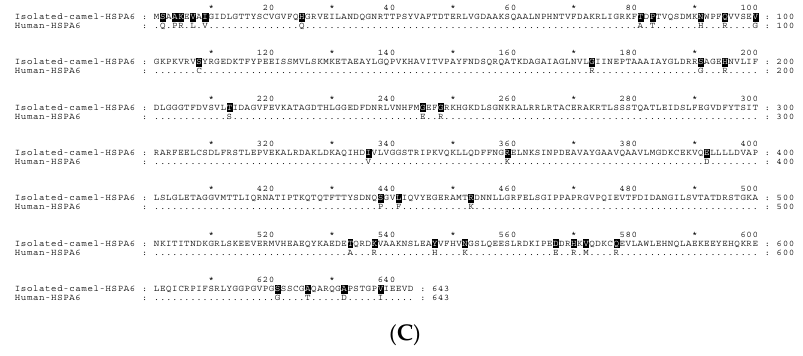
Figure 1. Homology analysis of the deduced amino acid sequences of cDNA clones of camel and human HSPs. Sequence alignment was produced by Clustal Omega and edited using GeneDoc version 2.7.000. ( A ) Amino acid alignment of camel and human CRYAB showing the four different amino acids shaded in black; ( B ) Alignment of isolated camel HSPA6 (GenBank, MG021195) with reported camel HSPA6 sequence (GenBank, ADO12067.1) showing amino acid variations at five amino acids as indicated by the black shaded positions; ( C ) Amino acid alignment of isolated camel HSPA6 (GenBank, MG021195) and human HSPA6 showing variant amino acids shaded in black. An asterisk indicates a number of ten amino acid residues while dots in the lower lines designate identical amino acid residues to the corresponding upper ones.